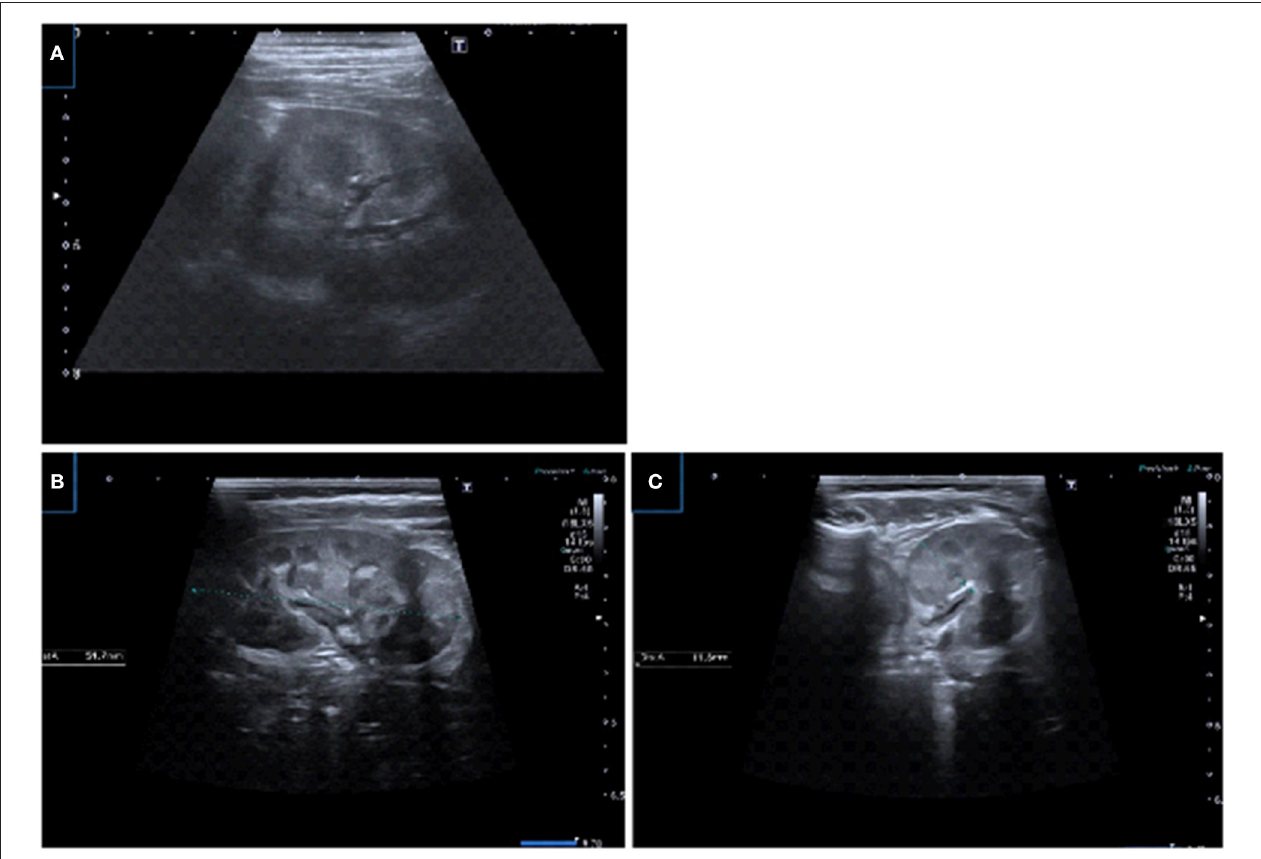
FIGURE 2 | US images using linear transducers. (A) Transverse US image demonstrating corticomedullary differentiation in prone position and detailed visualization of the parenchyma. (B,C) Renal longitudinal and transverse US images in prone position demonstrating physiologic medullary echogeneity with corticomedullary differentiation and uroepithelial thickening in